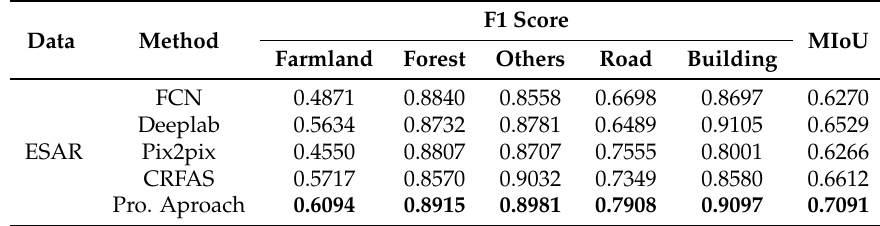
Table 6. F1 score and mean intersection over union (MIoU) of ESAR data.